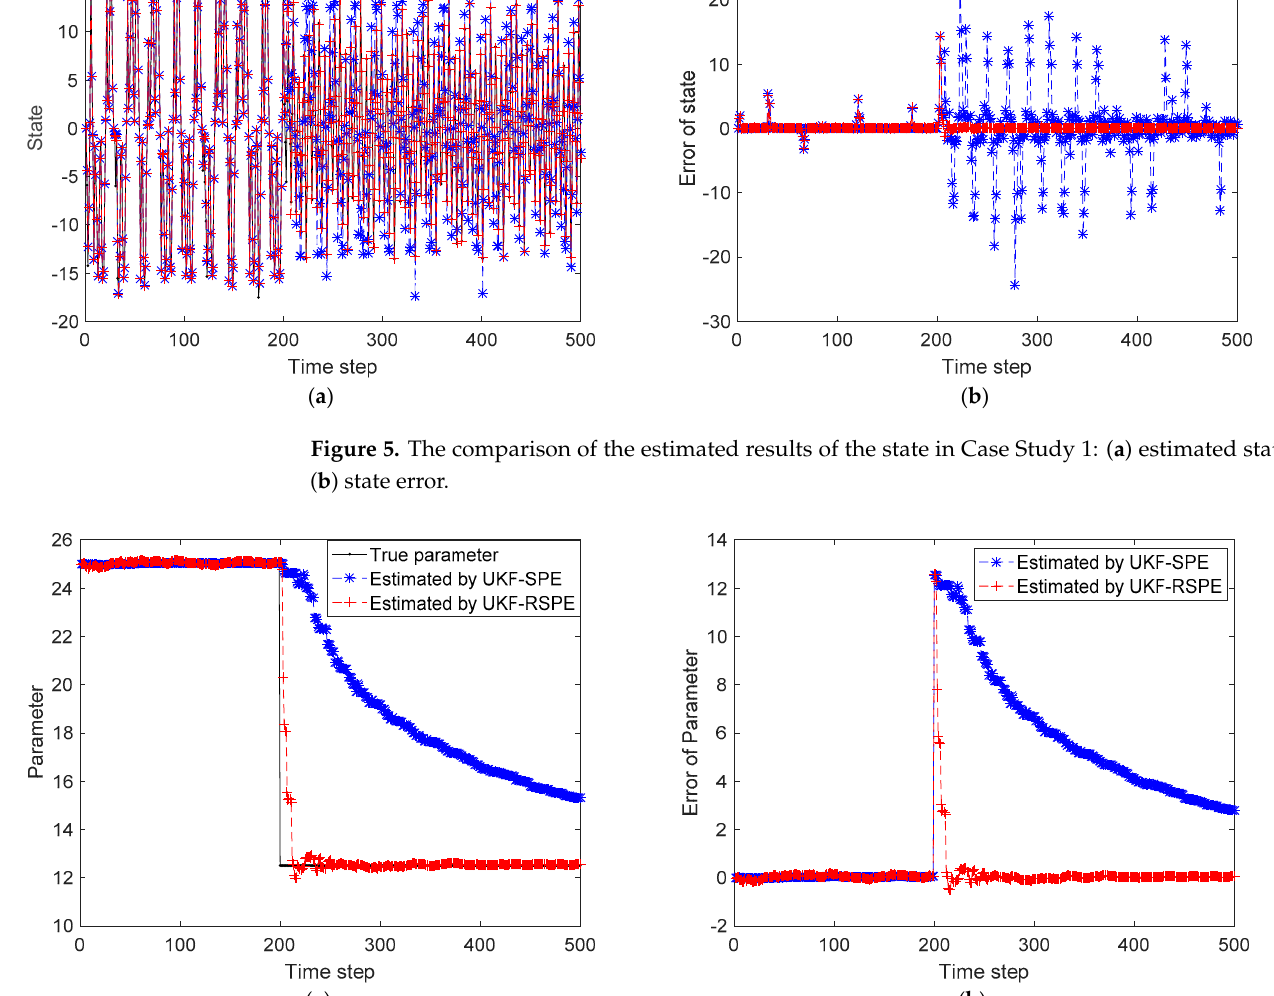
( b ) Figure 7. The comparison of the reconciled results of measurement in Case Study 1: ( a ) reconciled measurement; ( b ) measurement error. Table 1. Statistical information of estimated results in Case Study 1. Results